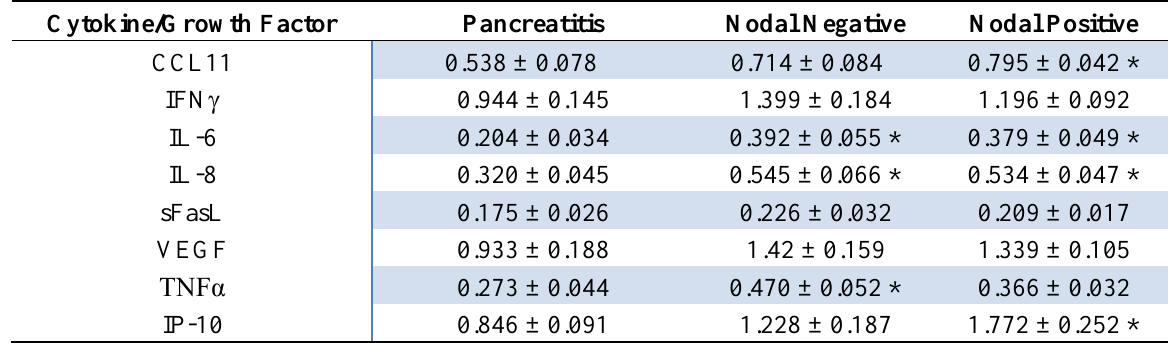
Table 2. Plasma Cytokine/Growth Factor